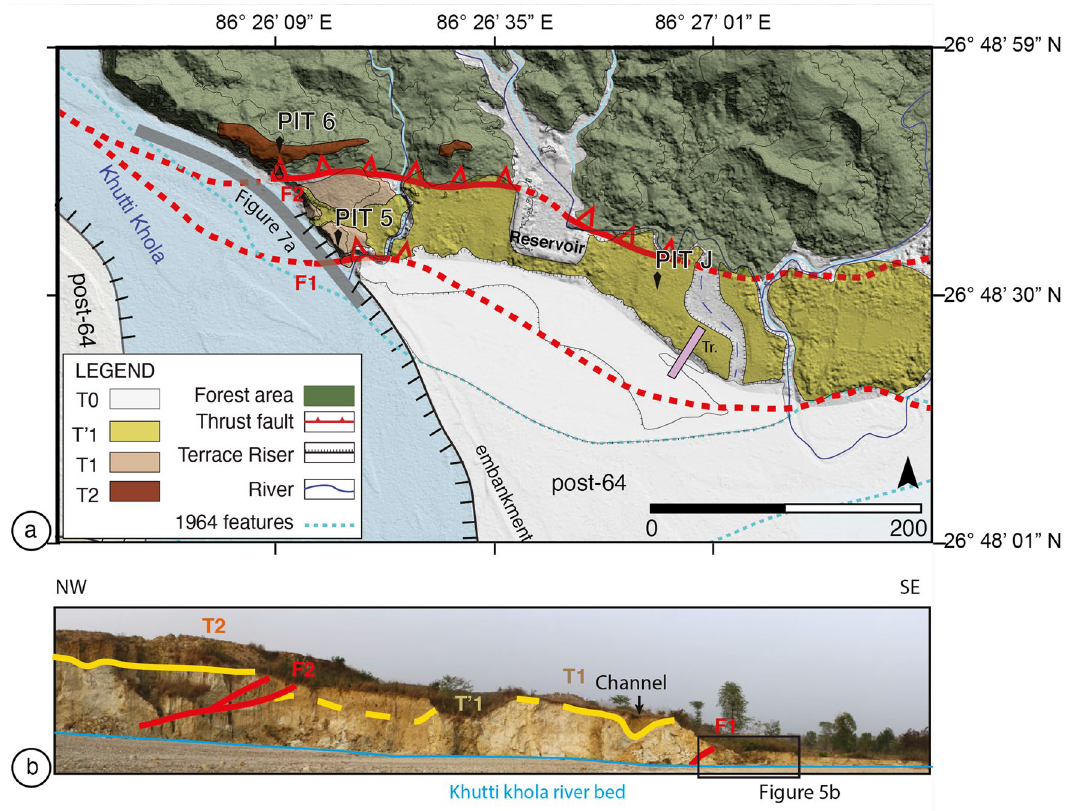
Figure 4. ( a ) Map of the active tectonics and geomorphology of the Khutti Khola site with the Main Frontal Thrust in red (see location Fig. 2). Grey line locates the river cut Fig. 7a. Tr. Trench with undeformed units. ( b ) Rivercut picture with the main geological features, the faults and the vertical offset between the current riverbed and the top of terraces T1 and T2. Yellow line represent the top of the Siwalik. Sampled pit and channel are logged in Fig. S3 from the Supplementary Materials, the black box locates the trench site. Figure generated with ENVI Classic (https:// www. l3har risge ospat ial. com/ Softw are- Techn ology/ ENVI), Adobe illustrator CC (http:// www. adobe. com/ fr/ produ cts/ illus trator. html) and MAPublisher